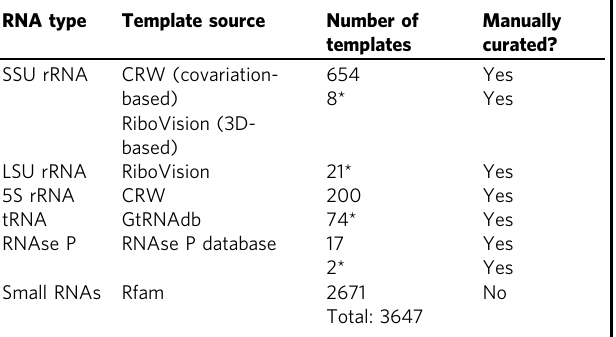
Table 1 The RNA 2D structure template library (* manually curated templates developed speci fi cally for this